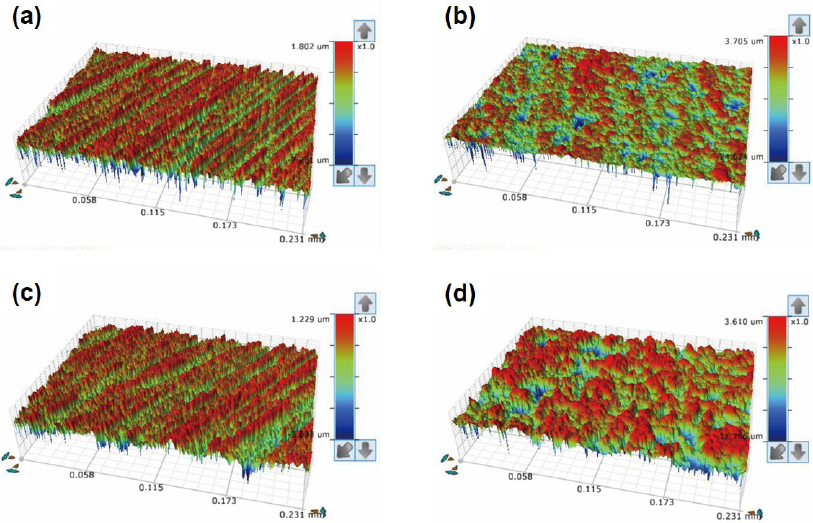
Figure 8. Representative 3D surface morphology images of both types of 3D printing resins for different surface treatments: ( a ) No surface treatment of Group 1; ( b ) APA of Group 1; ( c ) no surface treatment of Group 2; and ( d ) APA of Group 2. Table 4. Ra values of both types of 3D printing resins for different surface treatments.